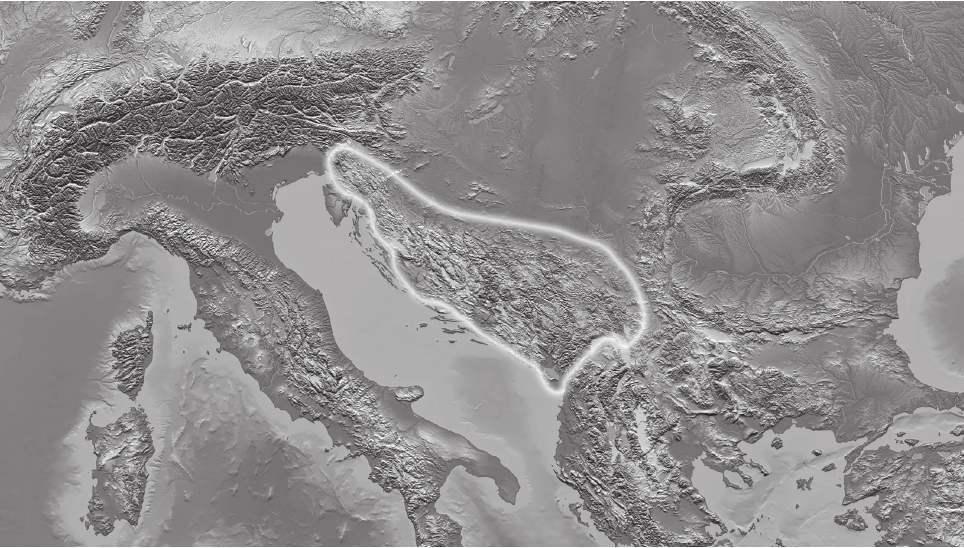
FIGURE 2 Borders of Dinaric Alps mountain range (Source: Zoom into Dinaric Alps mountain range,